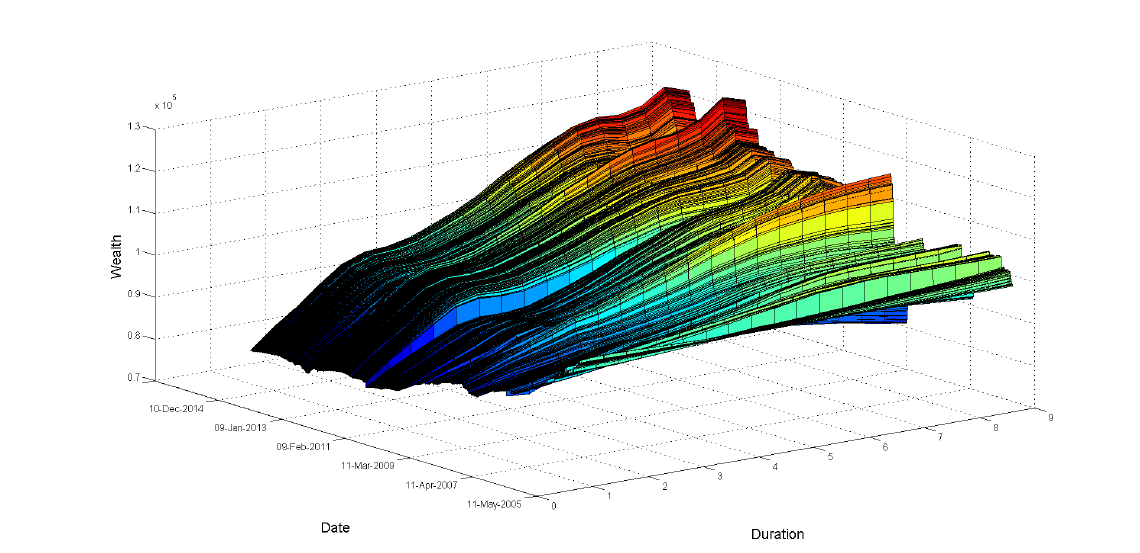
Figure 3. Ex-post wealth on Indian bond portfolios after first phase (May 2011–April 2015)